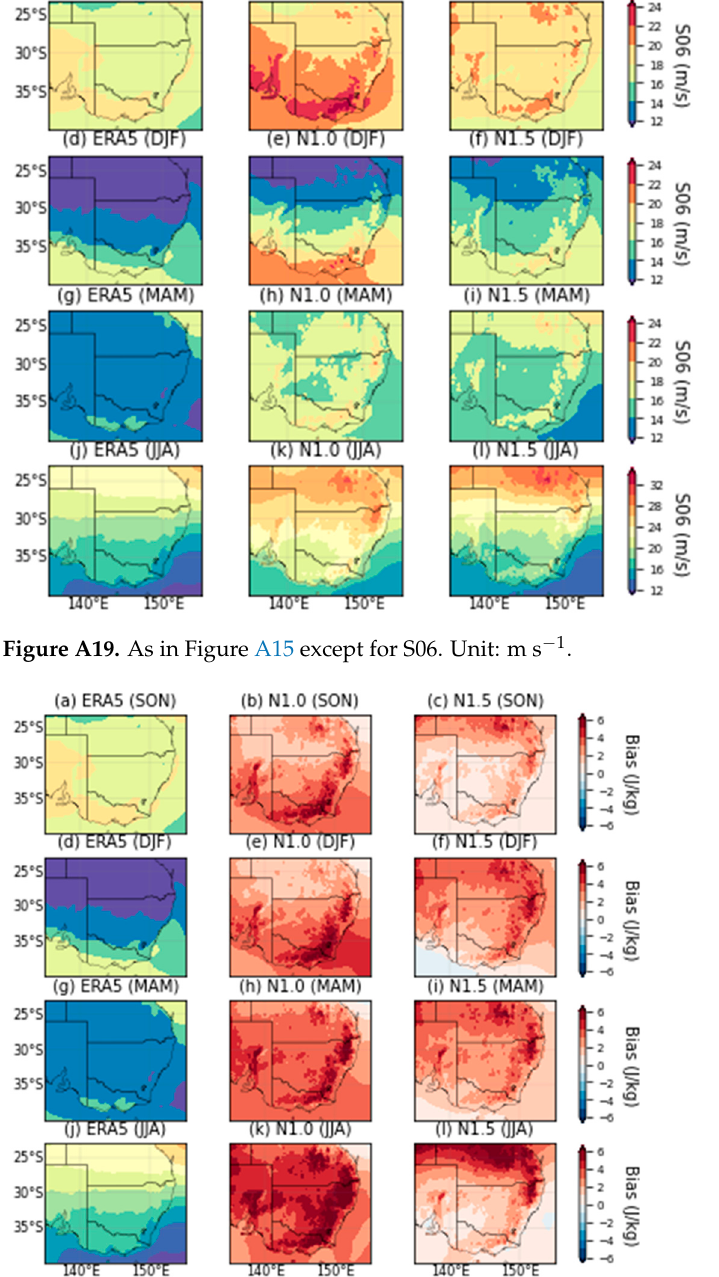
Figure A20. As in Figure A16 except for S06. Unit: m s − 1 .